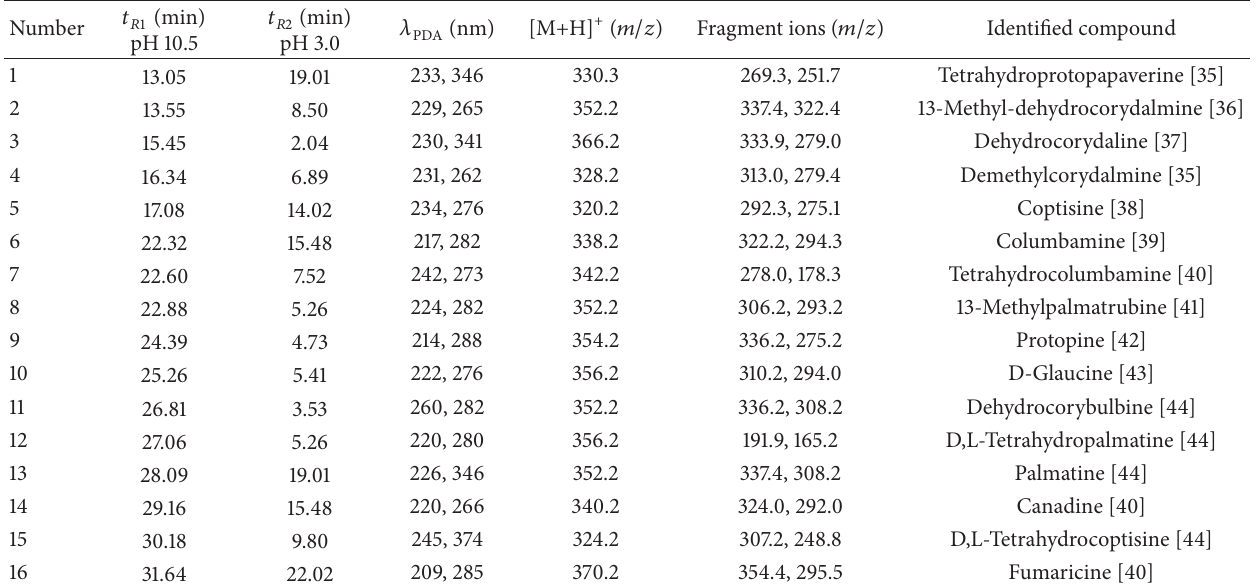
Table 1: Identified alkaloids in C. yanhusuo with MS/MS and UV